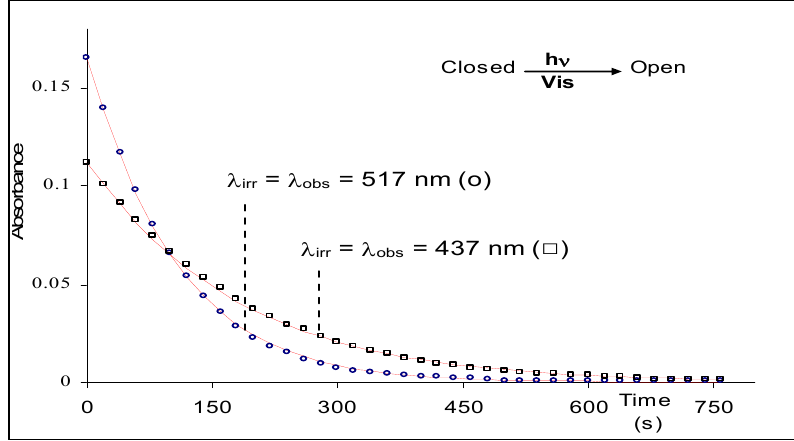
Figure 5. Photokinetic traces in hexane solution (1.82 10 -5 M ( ο ) and 3.28 10 -5 M ( □ ); 15°C) at two irradiation wavelengths in the visible. Experimental data (circles and squares) are readily fitted by the theoretical model, Eq.19a (lines) [reprinted from Ref. 93 with permission of the Journal of Photochemistry and Photobiology: A